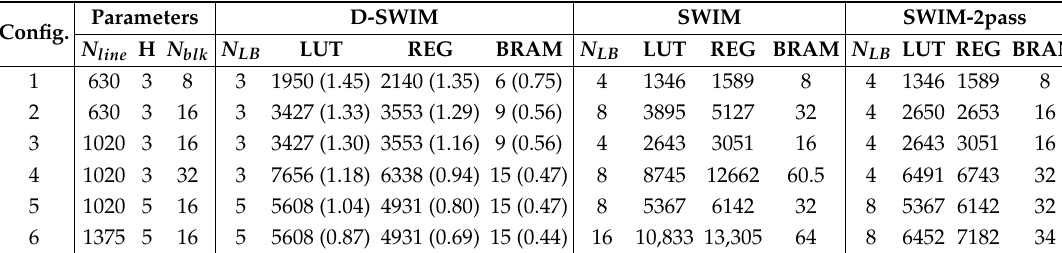
Table 3. Buffer resource consumption in SWIM and D-SWIM. Config.